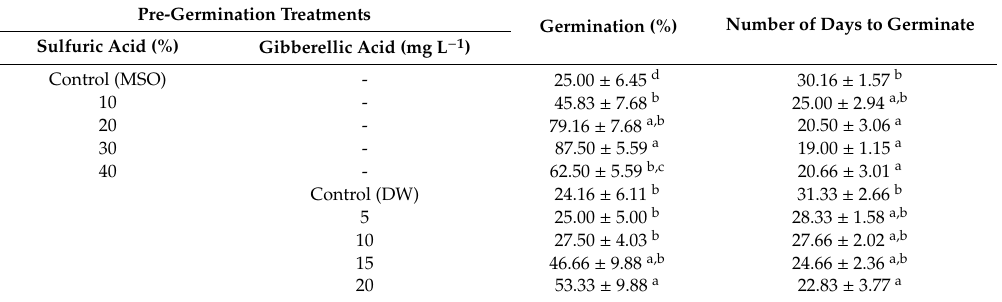
Table 2. Breaking seed dormancy of A. longiloba seeds by sulfuric acid treatment with seed coat